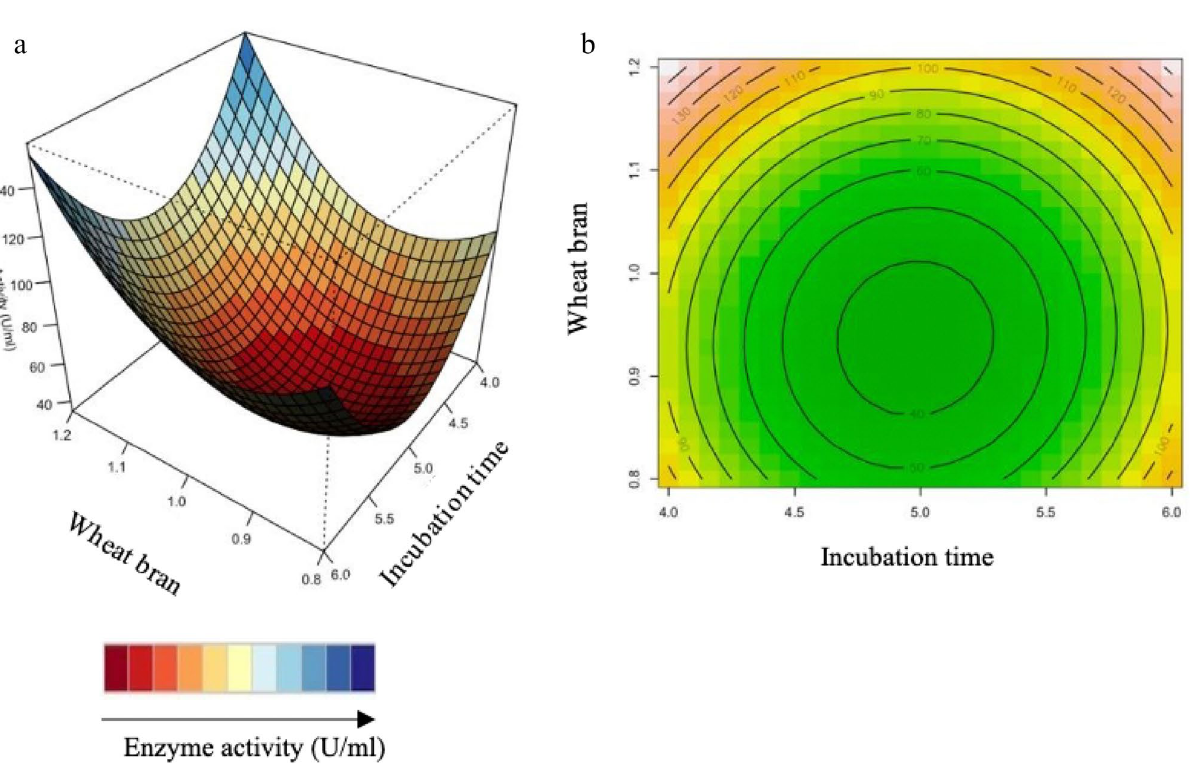
Figure 5. 3D-response surface plots ( a ) and contour plots ( b ) of the combined effects of Incubation time (X 2 ) and wheat bran (X 5 ) on xylanase production by Trichoderma harzianum